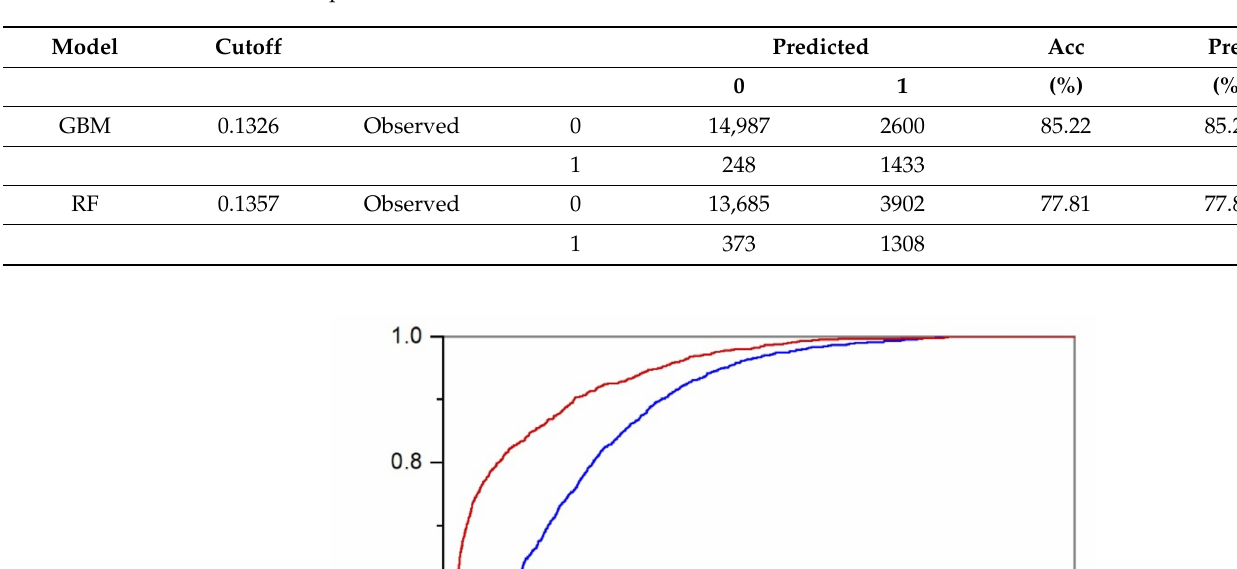
Table 3. Classification tables for the study area dataset based on GBM and RF models after appli- cation of cutoff values based on the sensitivity equal-specificity method, along with accuracy and precision values.